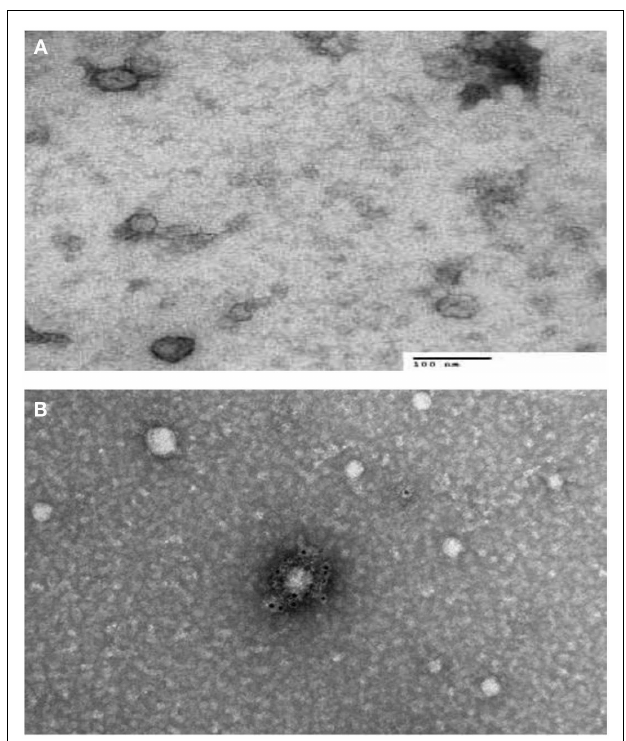
FIGURE 1 |Transmission electron microscopy (TEM) characterization of human serum derived extracellular vesicles (ECVs). (A) ECVs were negatively stained with 2% uracyl acetate after removing the extra moisture. Cup-shaped structures, with 30–100nm size were identified as being exosome/microvesicles. (B) ECVs isolated from human serum expressing CD63Transmembrane protein which is believed to be exosome/microvesicles marker. ECVs were immuno-gold labeled with rabbit polyclonal Abs against